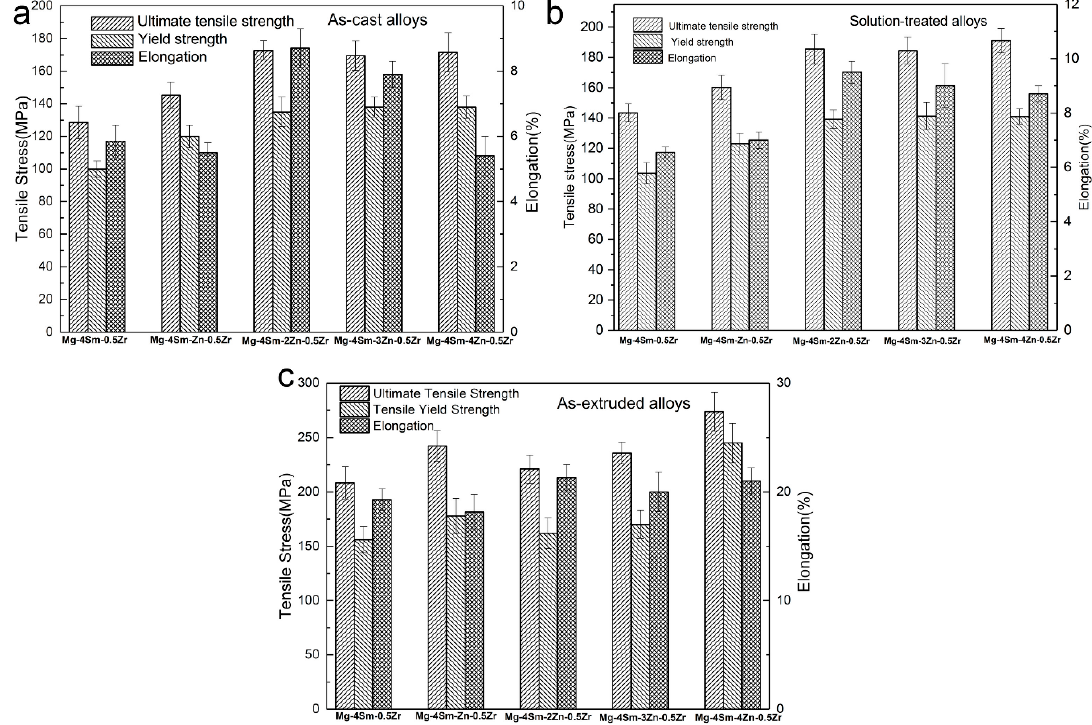
Figure 14. The tensile properties of as-cast, solution-treated and as-extruded Mg–4Sm– x Zn–0.5Zr ( x = 0, 1, 2, 3, 4 wt %) alloys at room temperature.